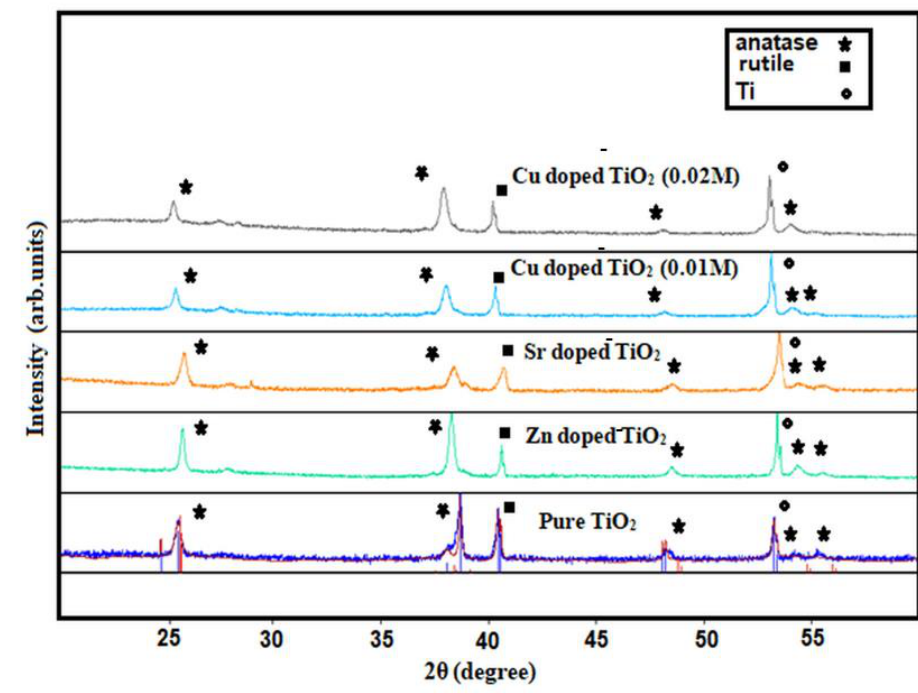
Figure 2. XRD patterns of pure and doped TiO 2 nanotube arrays after